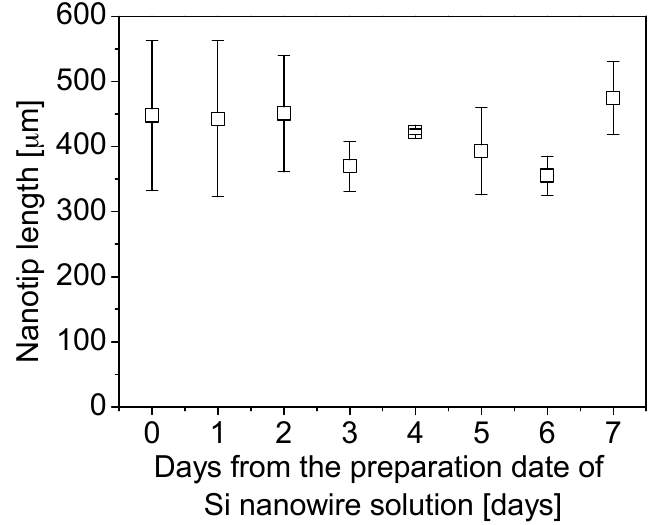
Figure 11. Average lengths of nanotips for seven days from the preparation date of a Si nanowire solution.